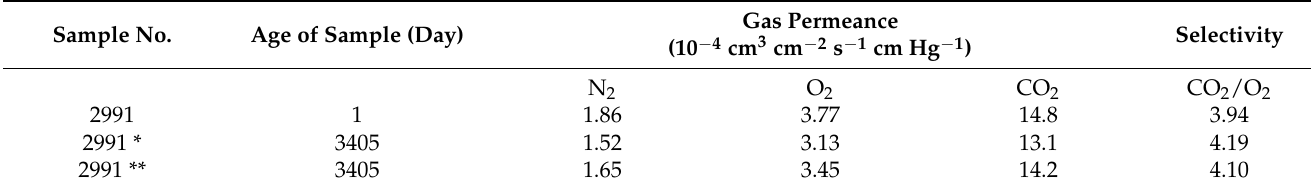
in the bulk of the